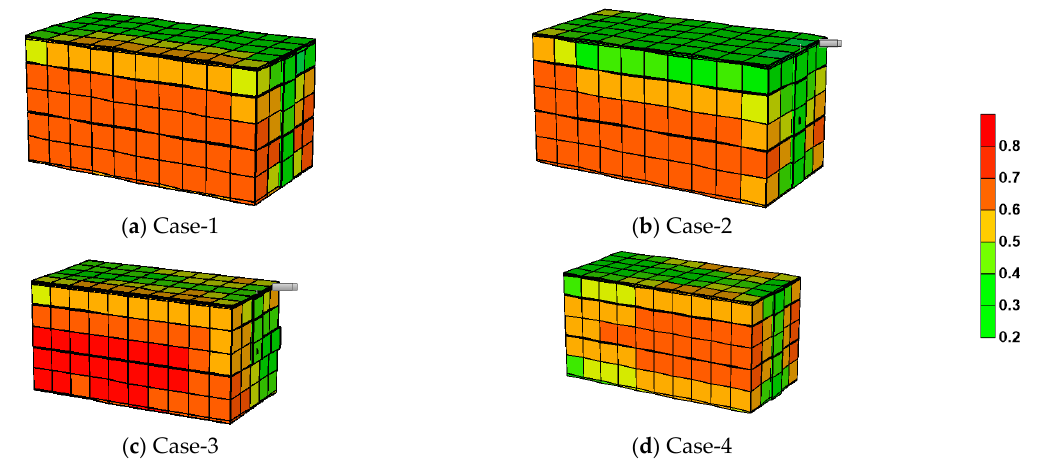
Figure 28. Oil Saturation comparison between different scattered fractures in CO 2 production process.